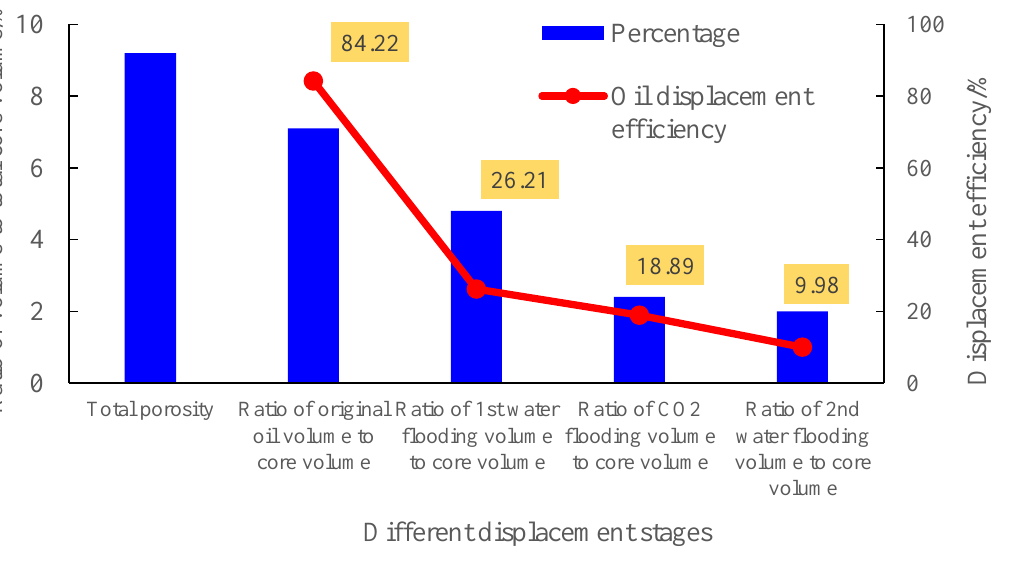
Figure 22. The Y56–19 core displacement efficiency and ratio of volume to total core volume in Figure 22. The Y56 – 19 core displacement efficiency and ratio of volume to total core volume in dif- different ferent stages.